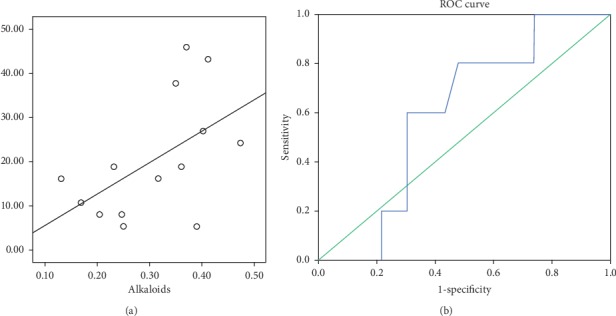
(a) Correlation coefficient of Nigerian honey antimicrobial activity against alkaloid content (r = 0.534, P=0.049). (b) Receiver operating characteristics to determine the optimal cutoff limit of alkaloid content in Nigeria honeys.